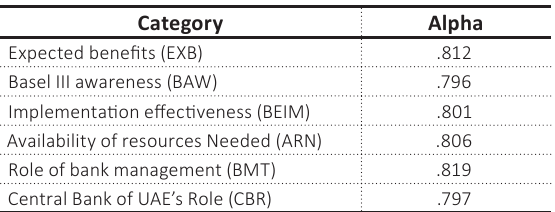
Table 2. Reliability of factors influencing the